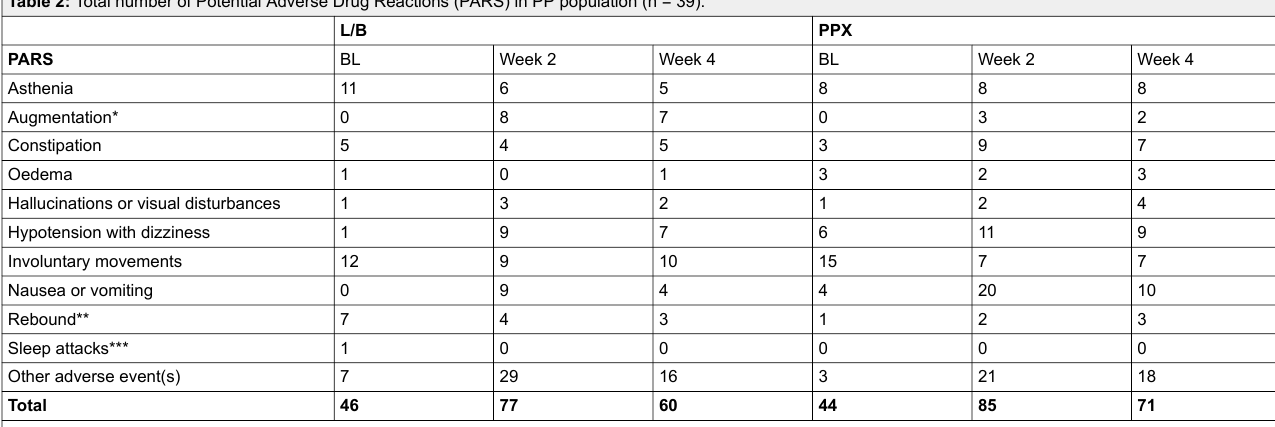
Table 2: Total number of Potential Adverse Drug Reactions (PARS) in PP population (n = 39).